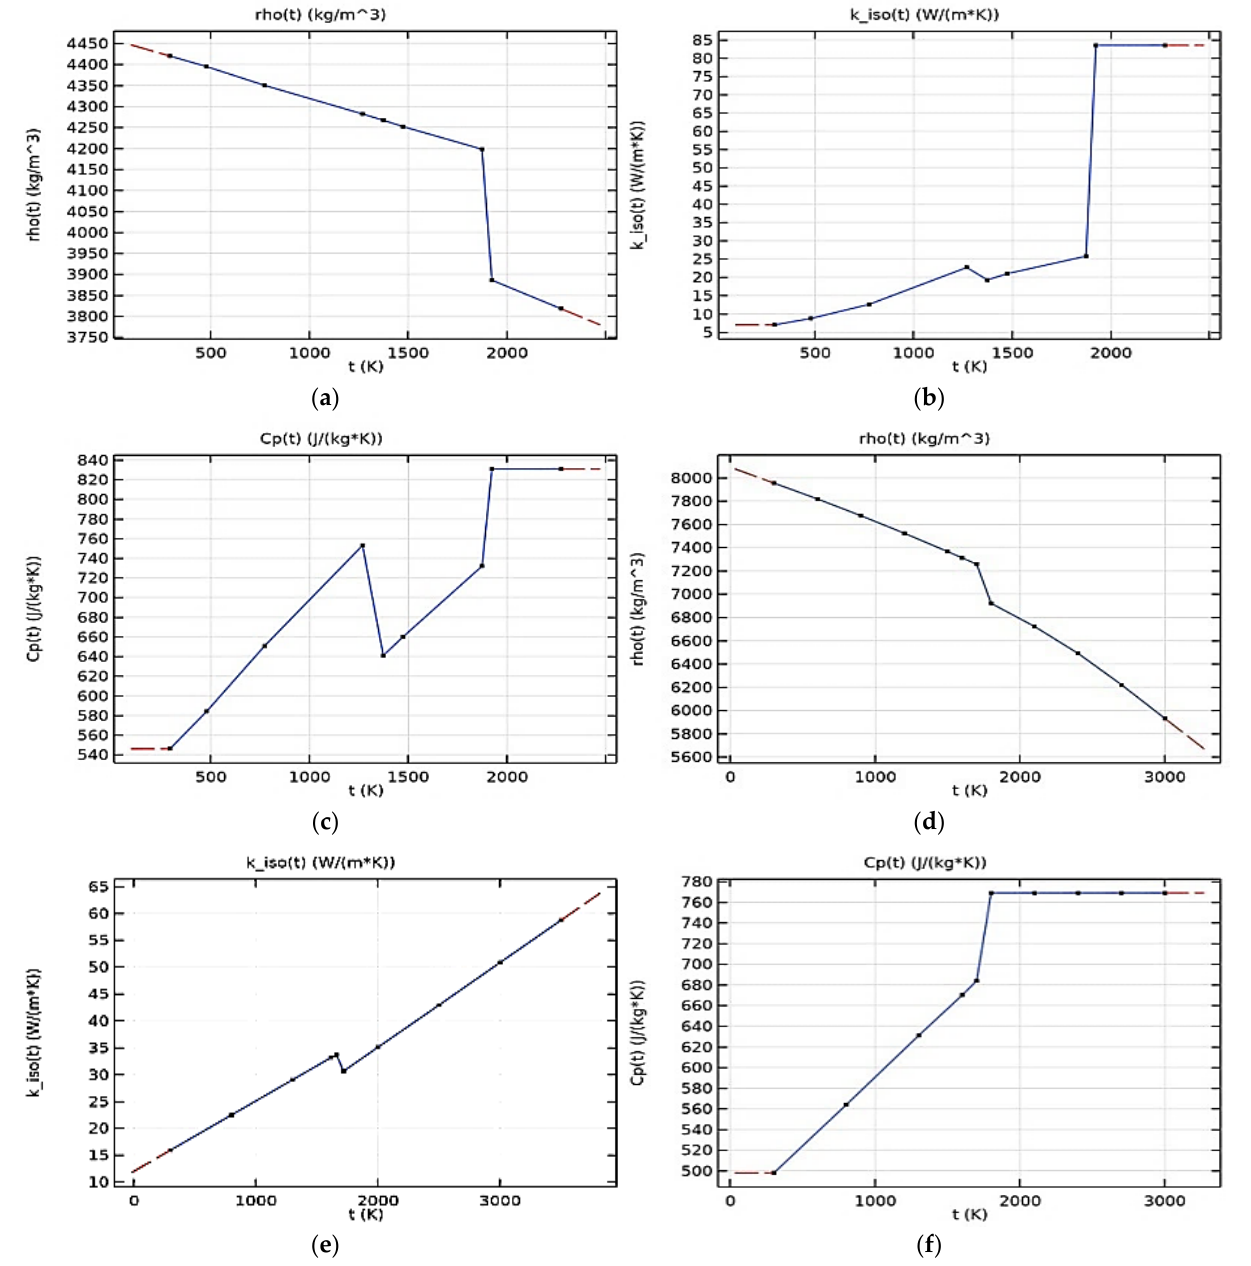
Figure 3. Temperature-dependent property plots for AISI 316L ( a – c ) and Ti-6Al-4V ( d – f ). Table 4. Constant